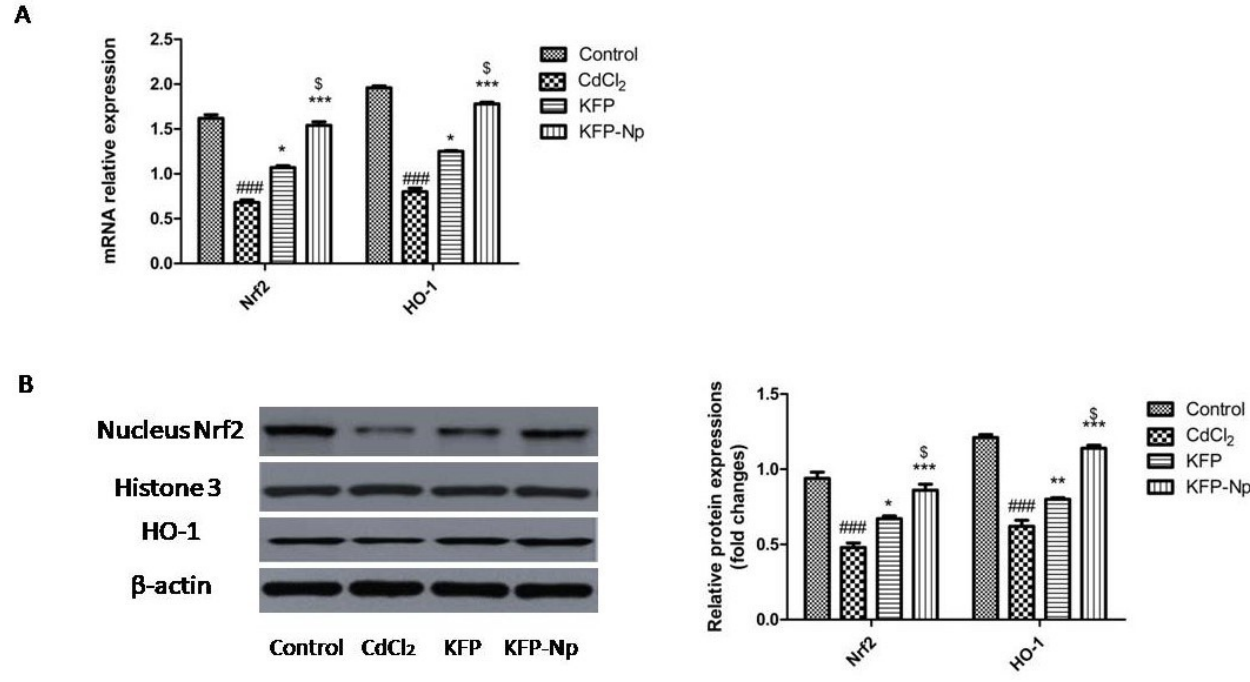
Figure 9. KFP-Np treatment significantly enhanced relative nucleus Nrf2 and HO-1 in liver tissues ofCdCl 2 -induced liver damage rat. The relative mRNA levels of HO-1 and nucleus Nrf2 in different groups were determined by RT-PCR and normalized to the β -actin ( A ). The protein expression levels of HO-1/ β -actin and nucleus Nrf2/Histone H3 in different groups were determined by Western blot ( B ). ### p < 0.001 significantly different from control group; * p < 0.05, ** p < 0.01 and *** p < 0.001, significantly different from the CdCl 2 group and $ p < 0.05, significantly different from the KFP group. Nrf2: nuclear factor-E2-related factor 2; HO-1: